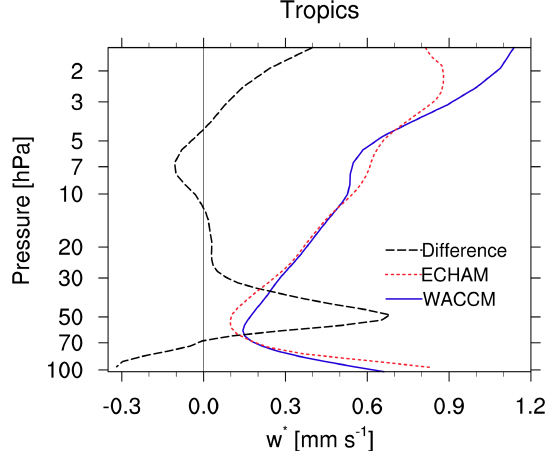
Figure 7. Residual vertical velocity of the control simula- tions in the tropics (averaged over 5 ◦ N to 5 ◦ S). Results of ECHAM (red) and WACCM (blue), and in black the difference – (WACCM − ECHAM )/